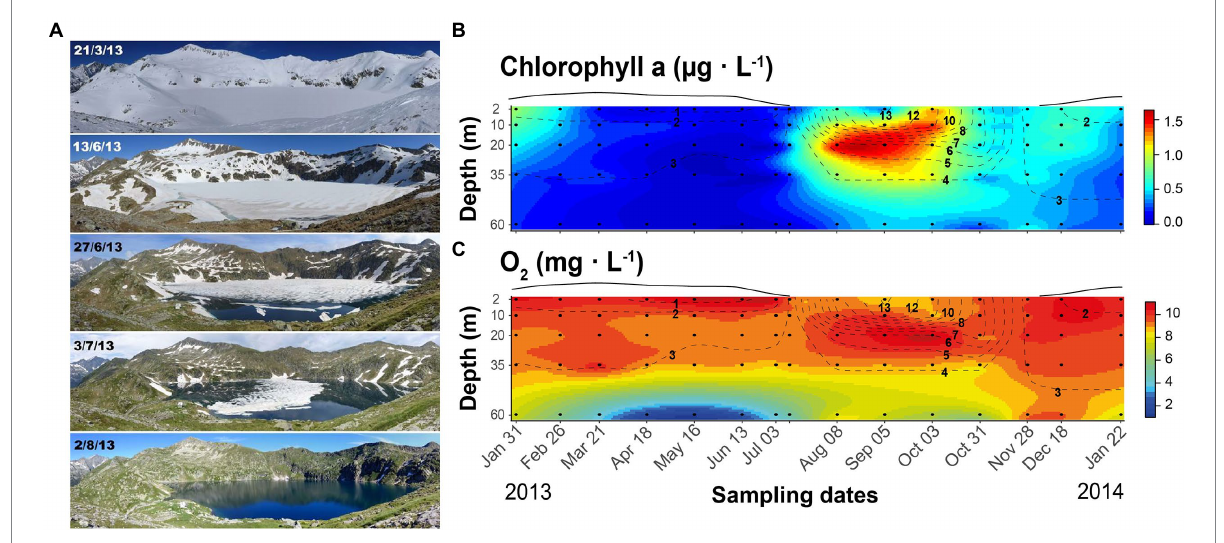
FIGURE 1 Seasonal changes in Lake Redon, Pyrenees. (A) Illustration of the snow and ice cover melting period. Photographs: Marc Sala-Faig. (B) Seasonal and depth variation of chlorophyll-a and (C) oxygen. Black circles indicate sampling points and dashed lines the isotherms ( ° C). The line above each graph indicates the snow and ice-cover thickness in arbitrary